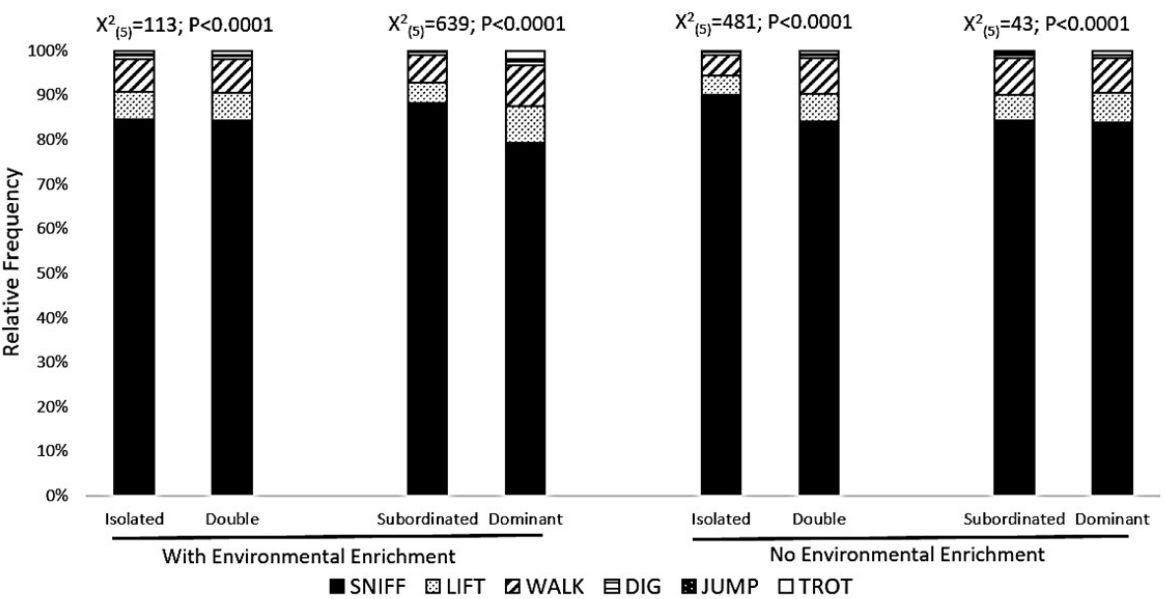
Figure 2. Relative frequency of motor patterns for the cate/gory Exploration. Absolute frequencies were compared between isolated and double animals and between subordinate and dominant animals using the chi-square test, with significantly higher values (P < 0.05) accompanied by an asterisk